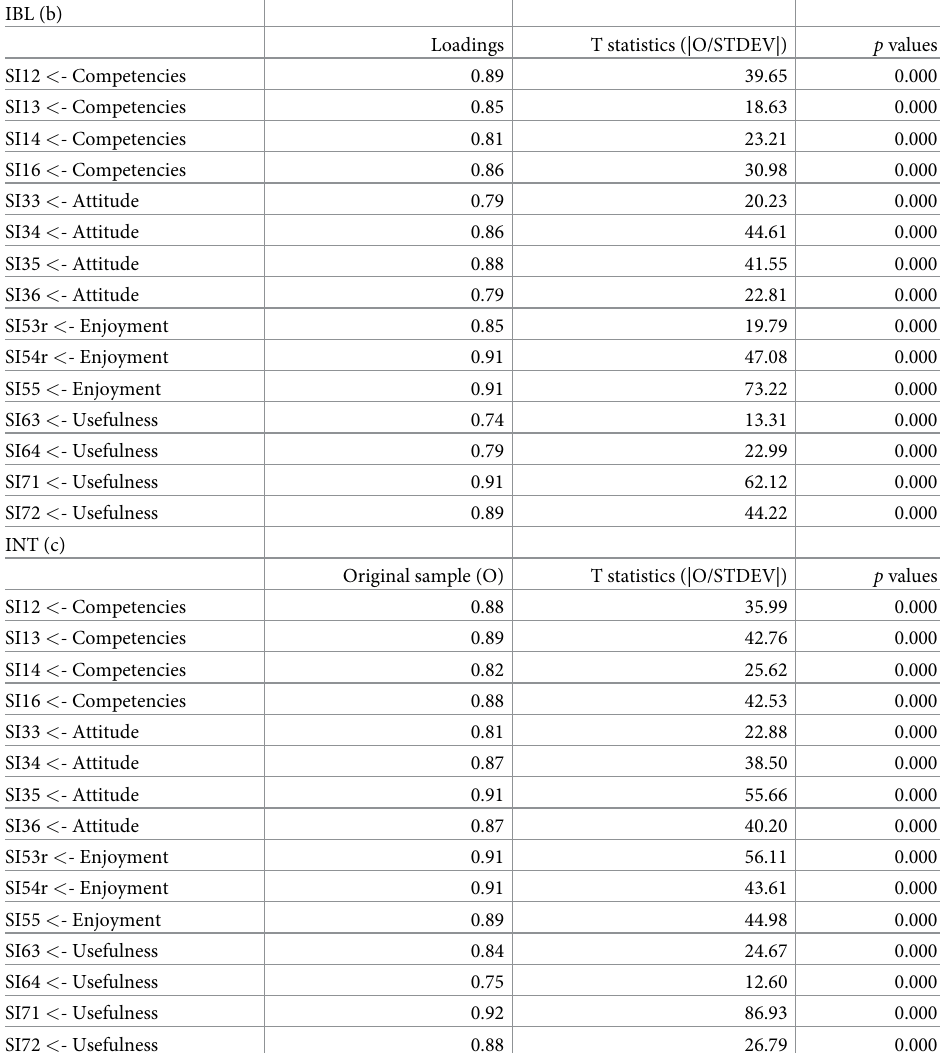
Table 5. CFA factor loadings, t statistics and significance level for IBL and INT teaching